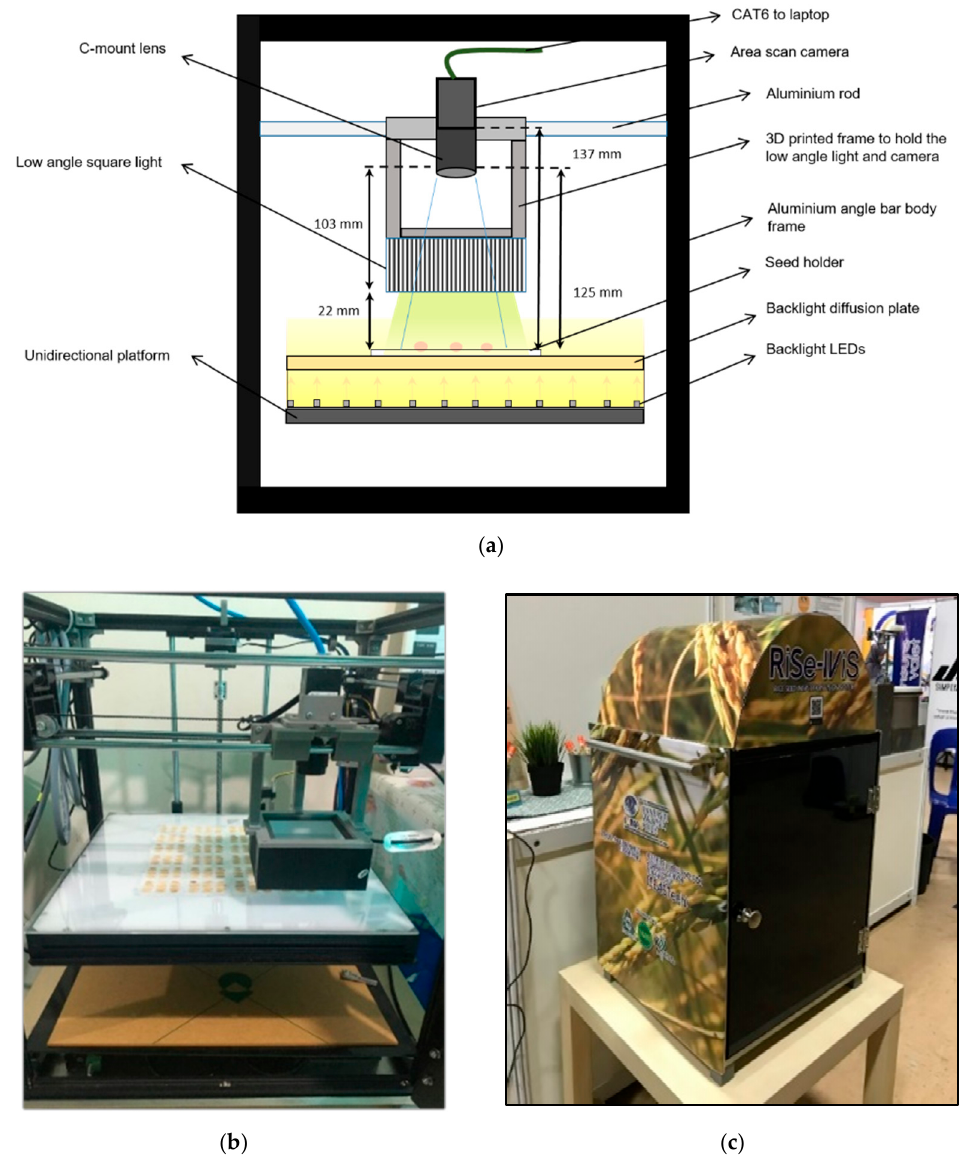
Figure 1. The weedy rice seed machine vision system ( a ) the schematic diagram ( b ) inside the prototype ( c ) the final look of the prototype from the outside.